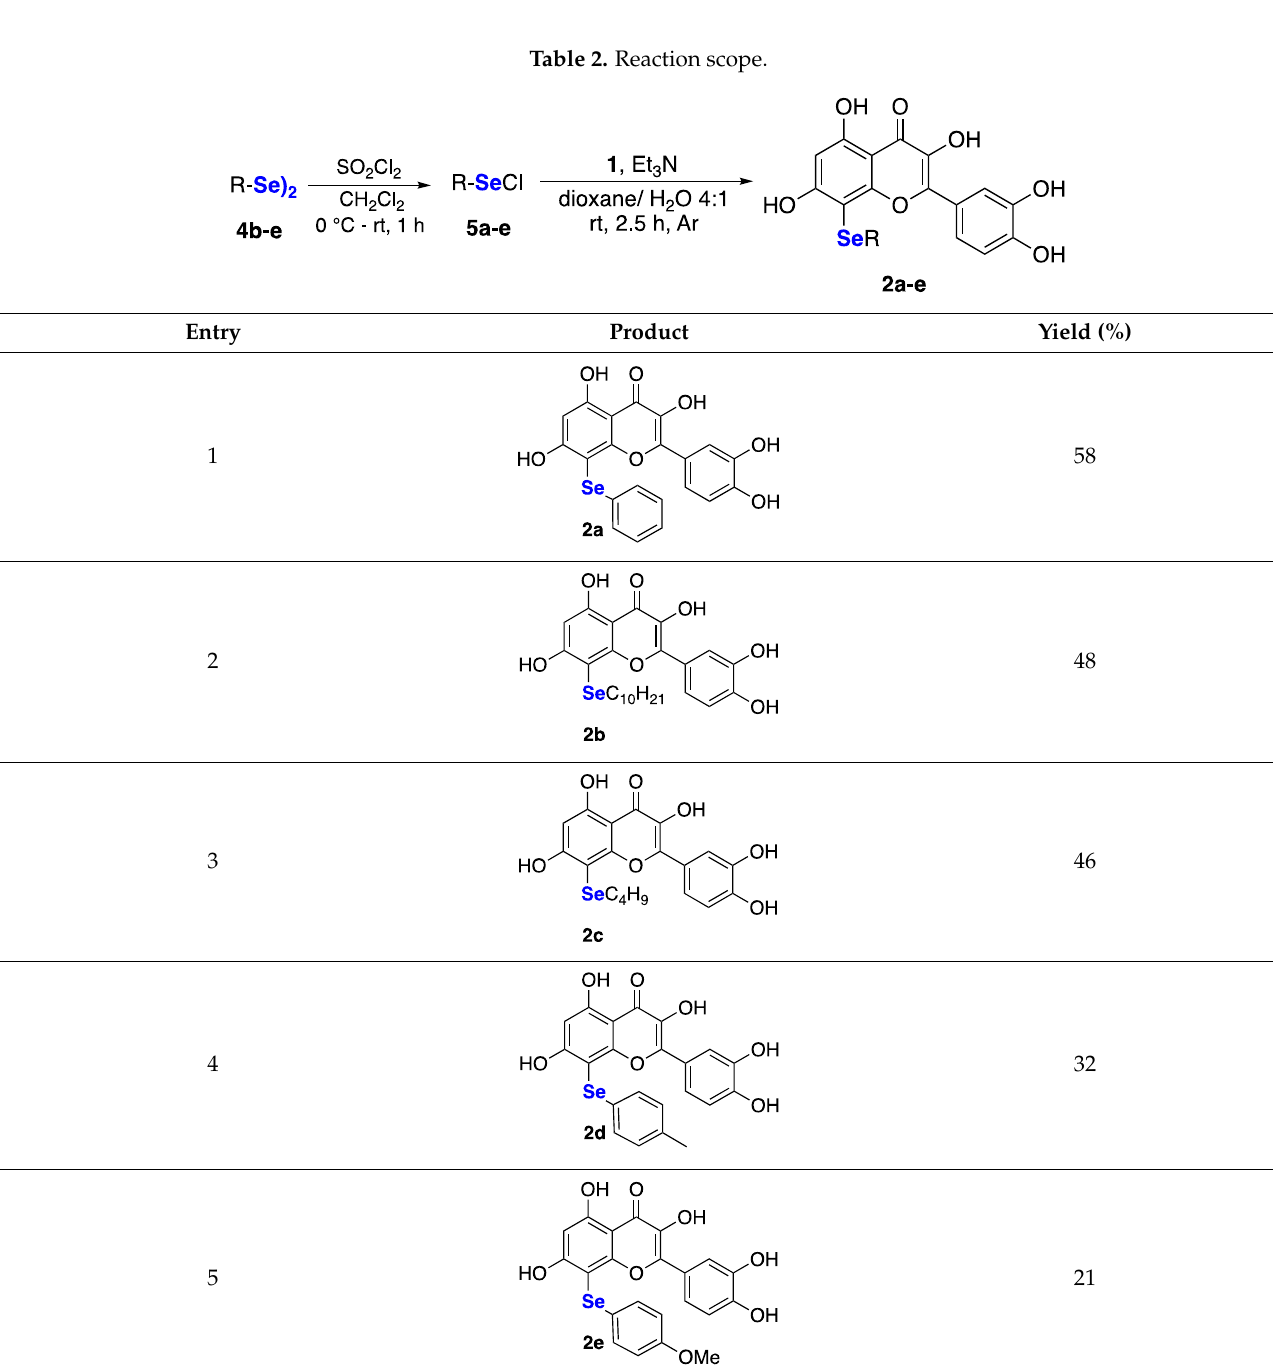
Table 2. Reaction Table 2. Reaction scope. Table 2. Reaction scope. Table 2. Reaction scope. Table 2. Reaction scope. Table 2. Reaction scope. Table 2. Reaction scope.